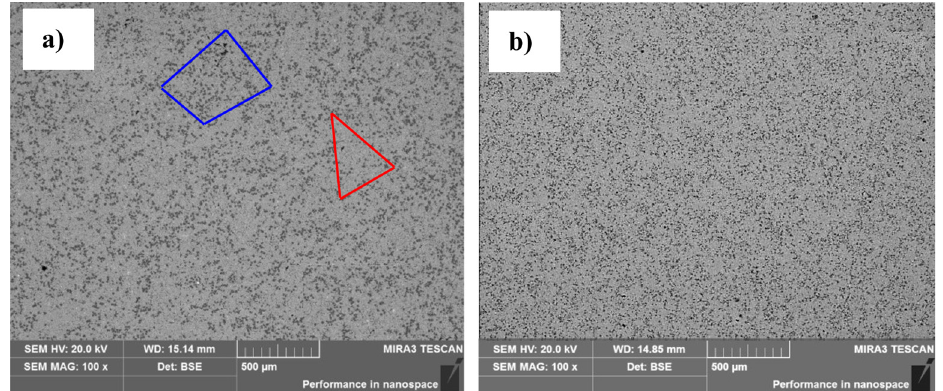
Figure 2: SEM - BSE images showing microstructures of as - cast samples: ( a ) 2.51 wt% Mn and ( b ) 4.52 wt% Mn, and black particles are the precipitates of